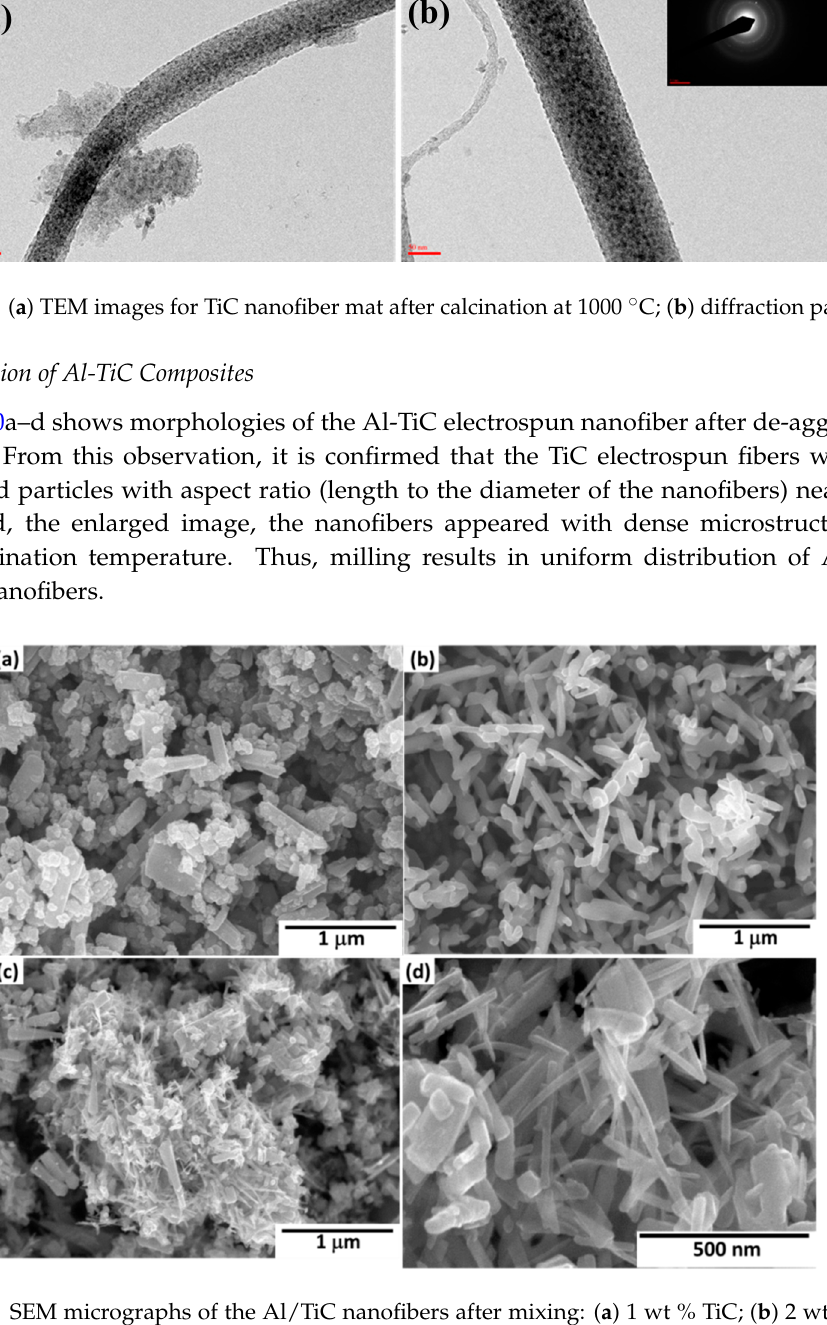
Figure 10. SEM micrographs of the Al/TiC nanofibers after mixing: ( a ) 1 wt % TiC; ( b ) 2 wt % TiC; ( c ) 3 wt % TiC; ( d ) 5 wt % TiC with high magnifications.